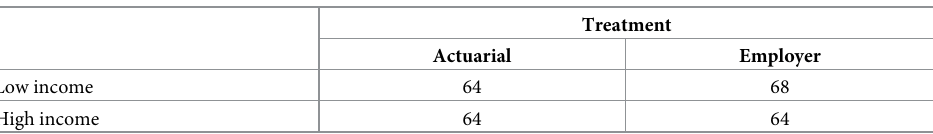
Table 1. Subjects per treatment